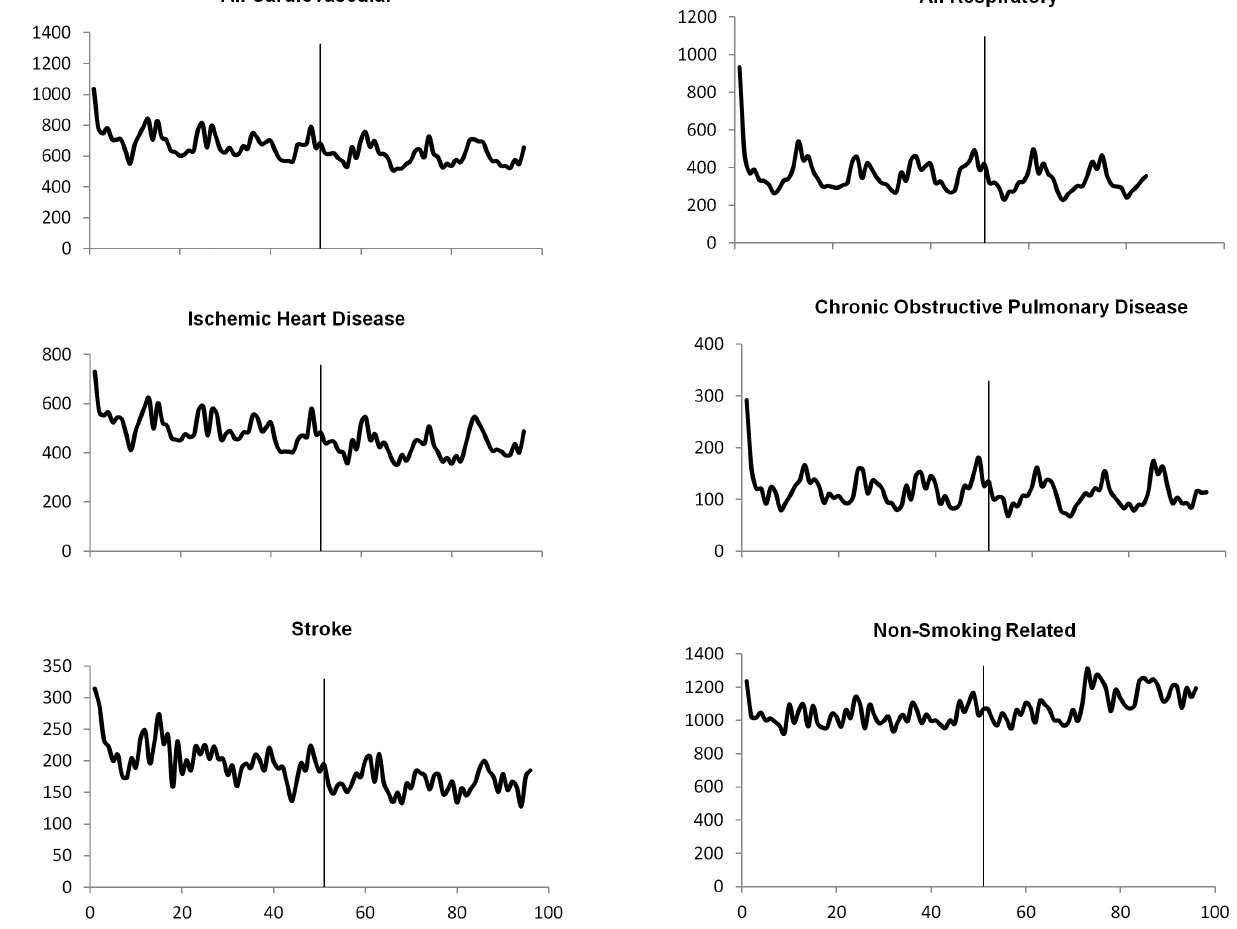
Figure 2. Observed Monthly Mortality in the Republic of Ireland, 2000–2007.* *All Respiratory excludes data from year 2007. The vertical line represents the month of smoking ban implementation. Monthly mortality is displayed rather than weekly for a clearer visual representation of